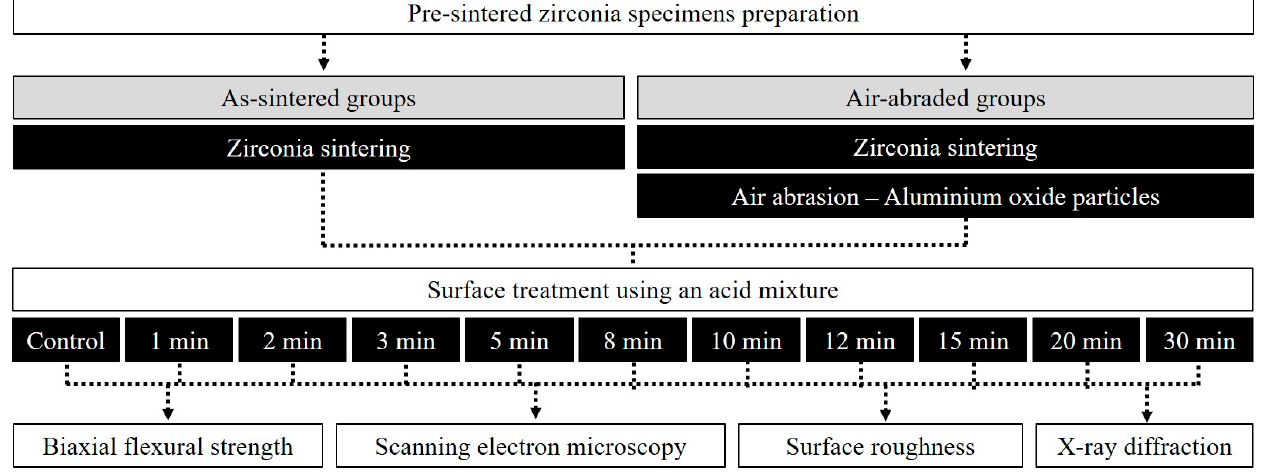
Figure 1. The workflow of surface treatment and analysis for specimens used in this study was conducted as follows.